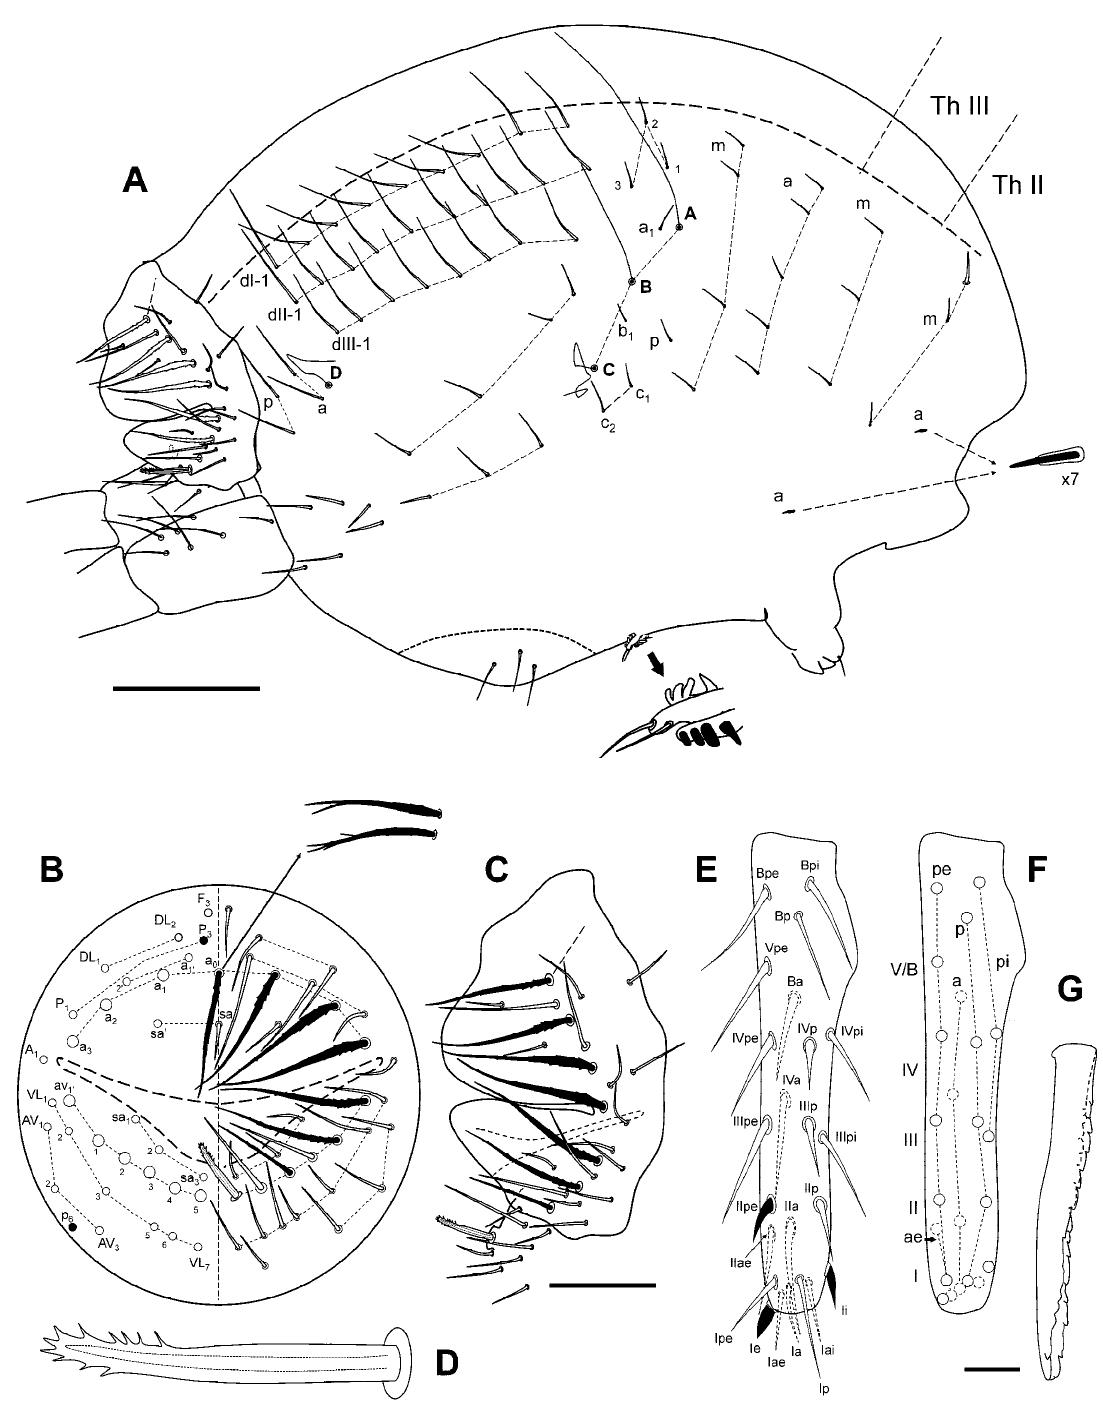
Figure 6. Pygmarrhopalites custodum Baquero and Jordana sp. nov.: ( A ) body, lateral view; ( B ) female anal valves schematized; ( C ) female anal valves, lateral view; ( D ) detail of the female anal appendage; ( E ) dens, posterior view; ( F ) dens, schematized; ( G ) mucro (scale bars: A, 0.1 mm; B–C, 0.05 mm; E–G, 0.02 mm).